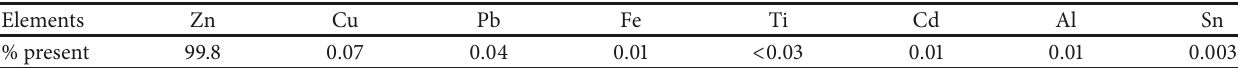
Table 2: Chemical composition of zinc.